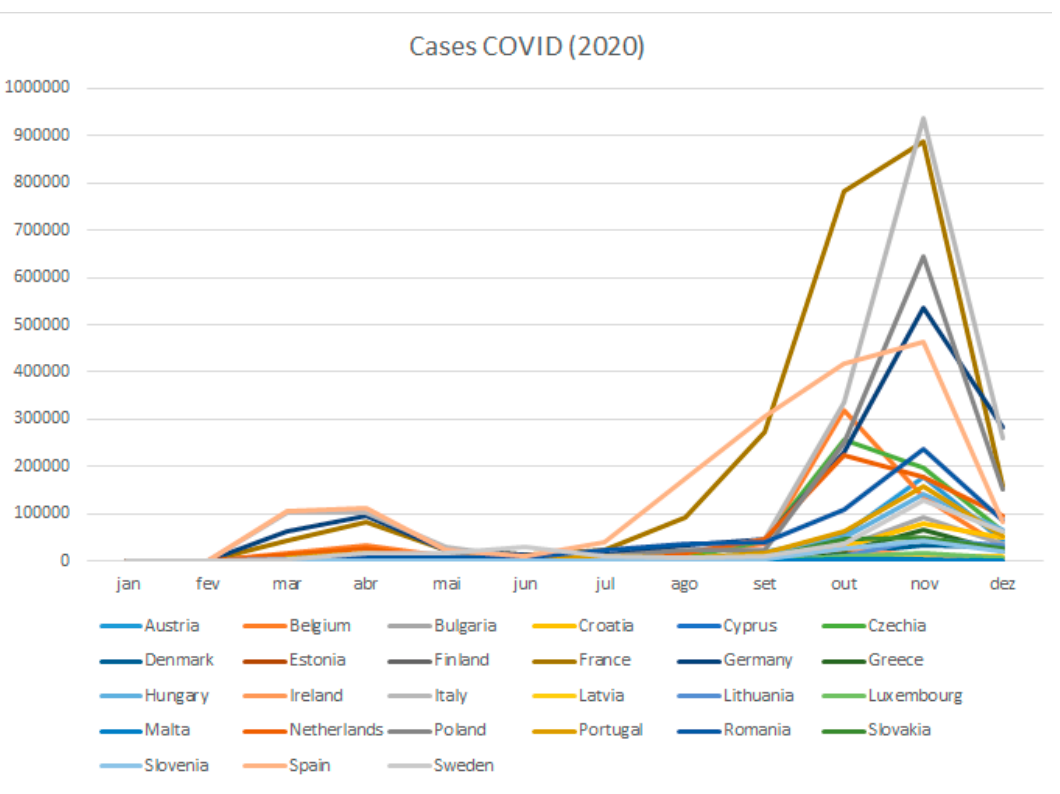
Figure 2. COVID-19 cases Eu27, 2020.